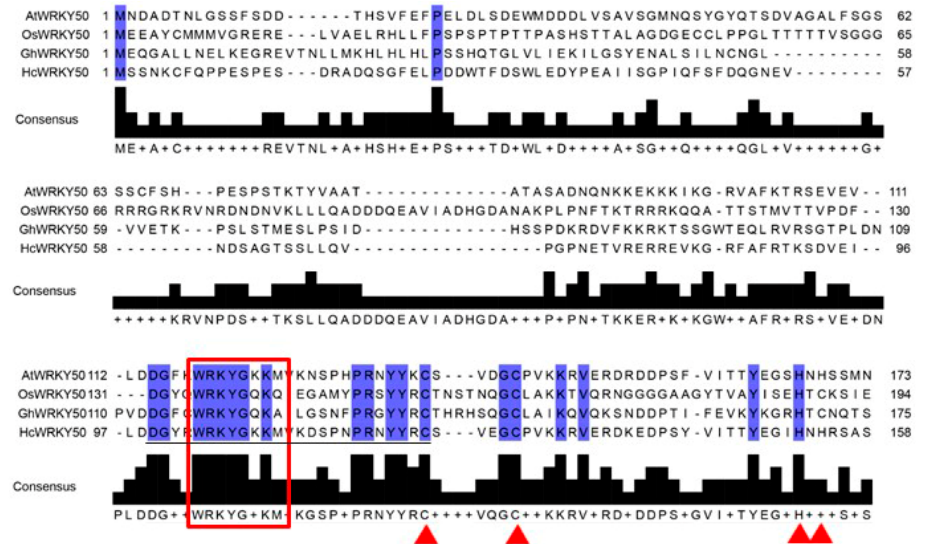
Figure 1. Sequence analysis of HcWRKY50 . Multiple sequence alignment of deduced amino acid sequences of HcWRKY50 with other WRKYs from Arabidopsis (AtWRKY50, NP_197989), rice (OsWRKY50, DAA05116), and cotton (GhWRKY50, AIE43840). Sequences were aligned using ClustalX. The typical WRKY domain is underlined, and the WRKYGQ(K)K amino acids that were completely conserved were boxed. Arrowheads indicate the cysteine and histidine residues of the putative zinc finger motif.